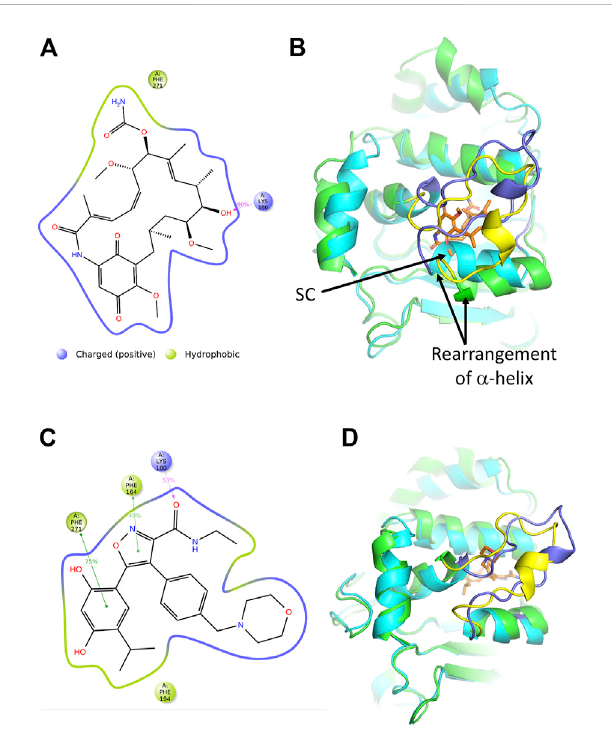
FIGURE 8 Analyses of the molecular dynamic model of sacsin-geldanamycin and sacsin-AUY922. (A) A schematic of detailed ligand atom interactions withtheproteinresidues.Interactionsthatoccurmorethan20.0%ofthe simulation time in the entire trajectory, are shown. It is possible to have interactions with > 100% as some residues may have multiple interactions of a single type with the same ligand atom. Hydrogen bond is shown in pink. (B) Superimposition of the MD models of sacsin-ATP (cyan with slate coloured lid) and sacsin-geldanamycin (green with yellow coloured lid), showinghow ahelix of sacsin isrearranged inorder toaccommodategeldanamycin. (C) Aschematicofdetailed ligandatom interactions with the protein residues. Interactions that occur more than 30.0% of the simulation time in the entire trajectory, are shown. It is possible to have interactions with > 100% as some residues may have multiple interactions of a single type with the same ligand atom. Hydrophobic interactions (such as pi-pi stacking) are shown in green, while hydrogen bond is shown in pink. (D) Superimposition of the MD models of sacsin-ATP (cyan with slate coloured lid) and sacsin-AUY922 (greenwithyellowcolouredlid).